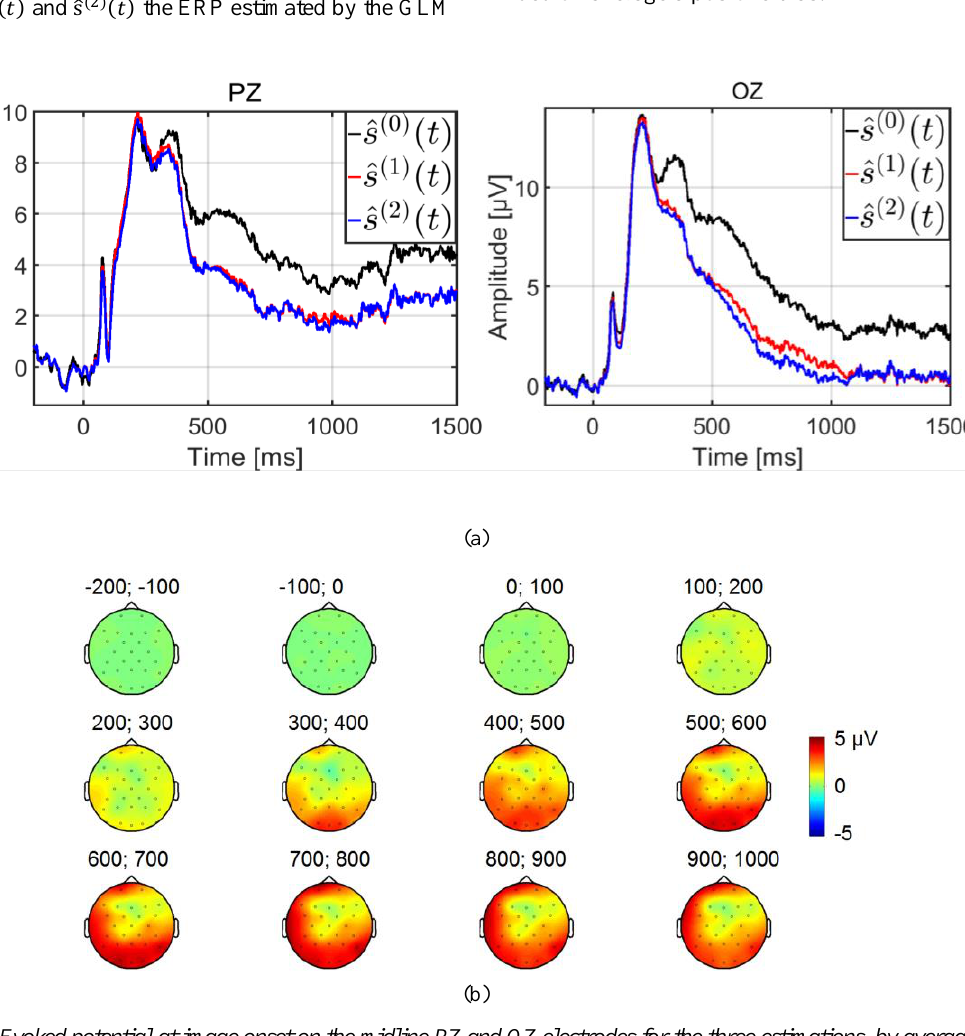
Figure 6 (a) Evoked potential at image onset on the midline PZ and OZ electrodes for the three estimations, by average 𝑠̂ (0) (𝑡) , by the two-class GLM 𝑠̂ (1) (𝑡) and by the three-class GLM 𝑠̂ (2) (𝑡) ; (b) Topographic maps of the difference between the two estimates: 𝑠̂ (0) (𝑡) − 𝑠̂ (1)